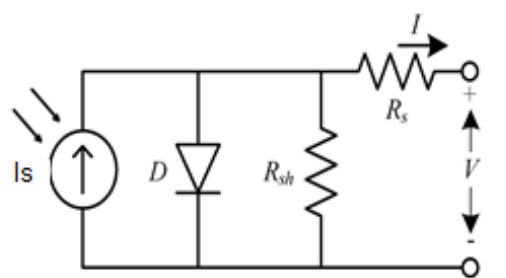
Figure 11. Equivalent circuit of a PV cell (1 diode and 5 parameters model-1M5P). The model parameters are I s , I 0 , n , R s , and R p , and thus the output current can be related to the output voltage based on expression 13